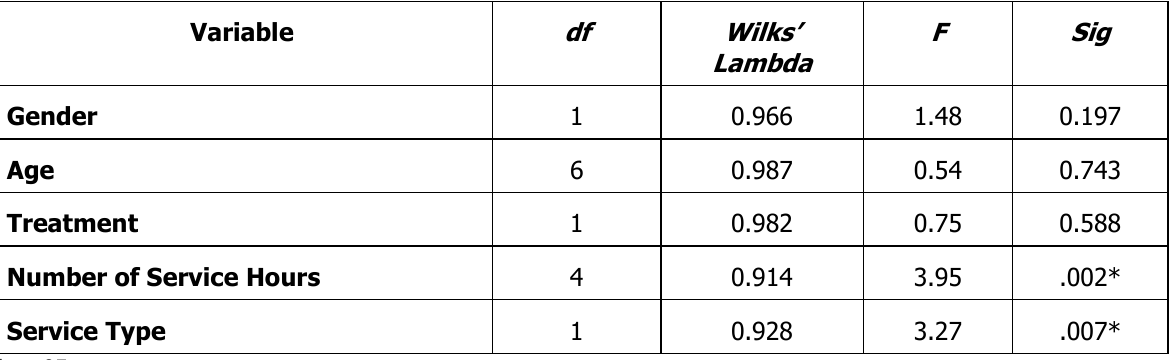
The Impact of Gender, Age, Treatment, Number of Service Hours and Service Type in the Development of Leadership Life Skills by Participants in a Service Activity at National Youth Service Day, El Paso and